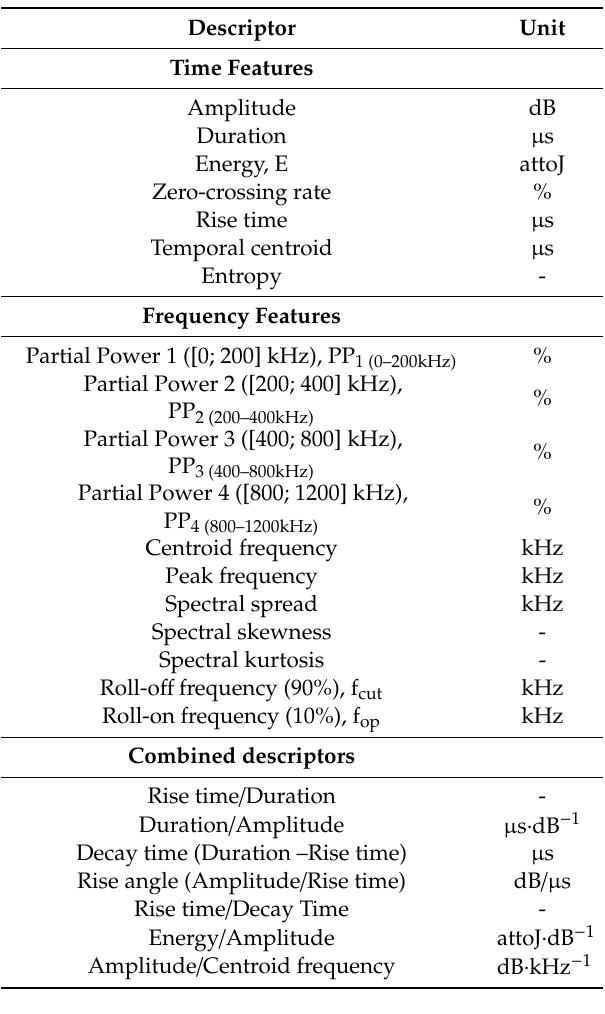
Table 1. Descriptors of AE signals extracted from the